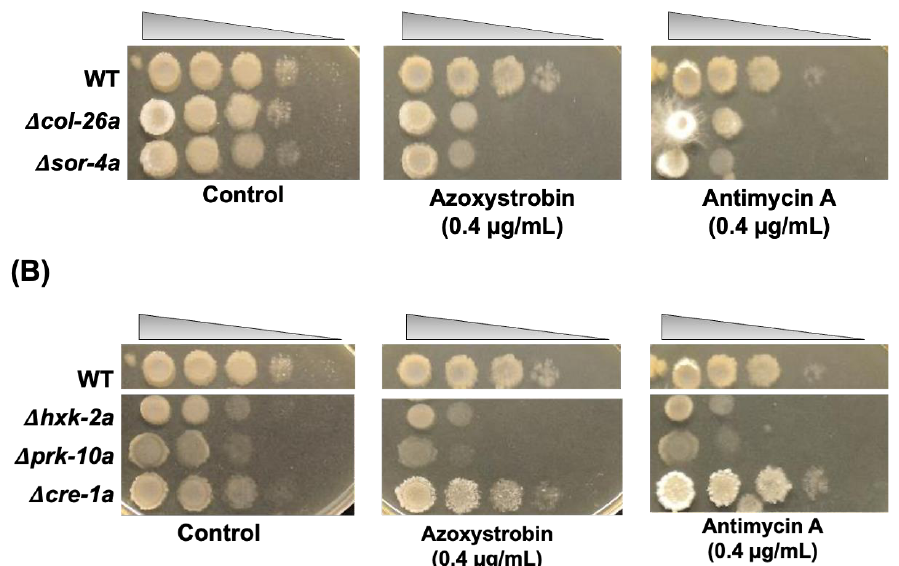
Figure 4. Sensitivity to the mitochondrial complex III inhibitors azoxystrobin and antimycin A. A series of conidia suspensions (10 7 –10 3 cells/mL) was spotted on sor medium containing azoxystrobin (0.4 mg/L) and antimycin A (0.4 mg/L) at room temperature. Control plates and fungicide treatment plates were photographed at 2 days and 5 days after inoculation, respectively. ( A ) col -26 and sor -4 strains. (B) hxk-2 , prk-10 and cre-1 strains.